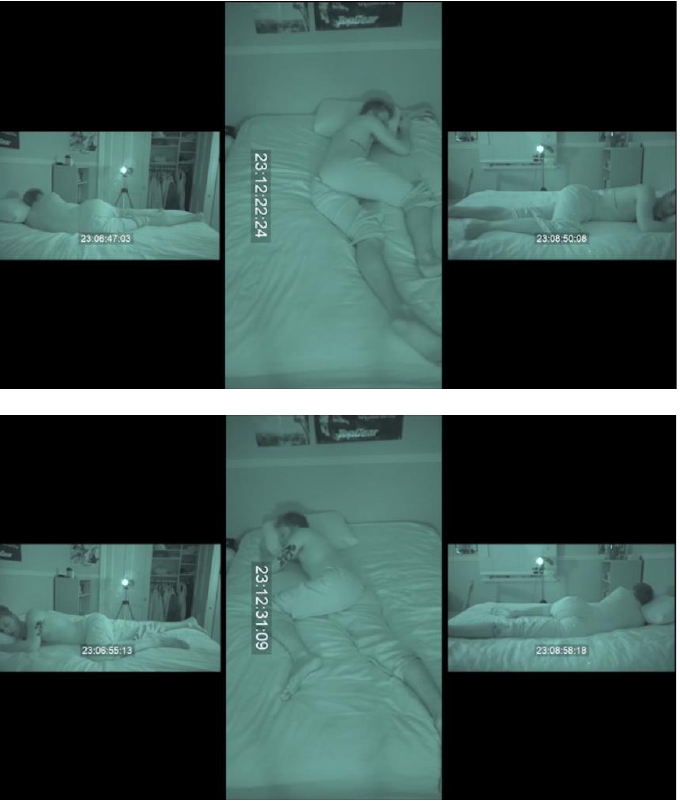
Figure 4. Example Frame of Clip Footage presented to human raters. * Reproduced with consent from pictured participant. Example Clip Video: https://youtu.be/SbKXkGrbrak (Accessed on 4 July 2021). July